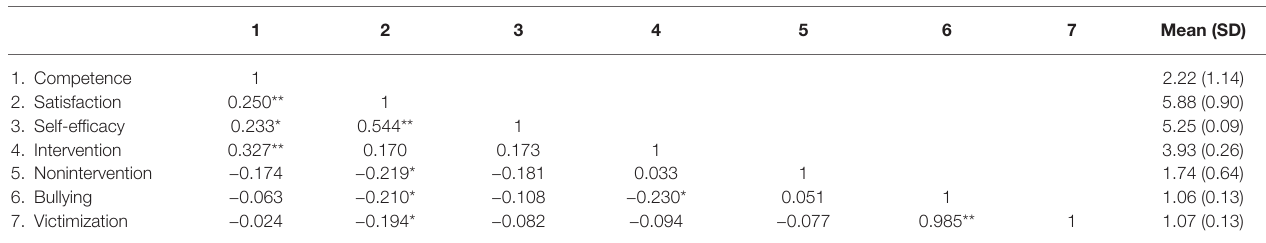
TABLE 1 | Correlations among study variables, means, and standard